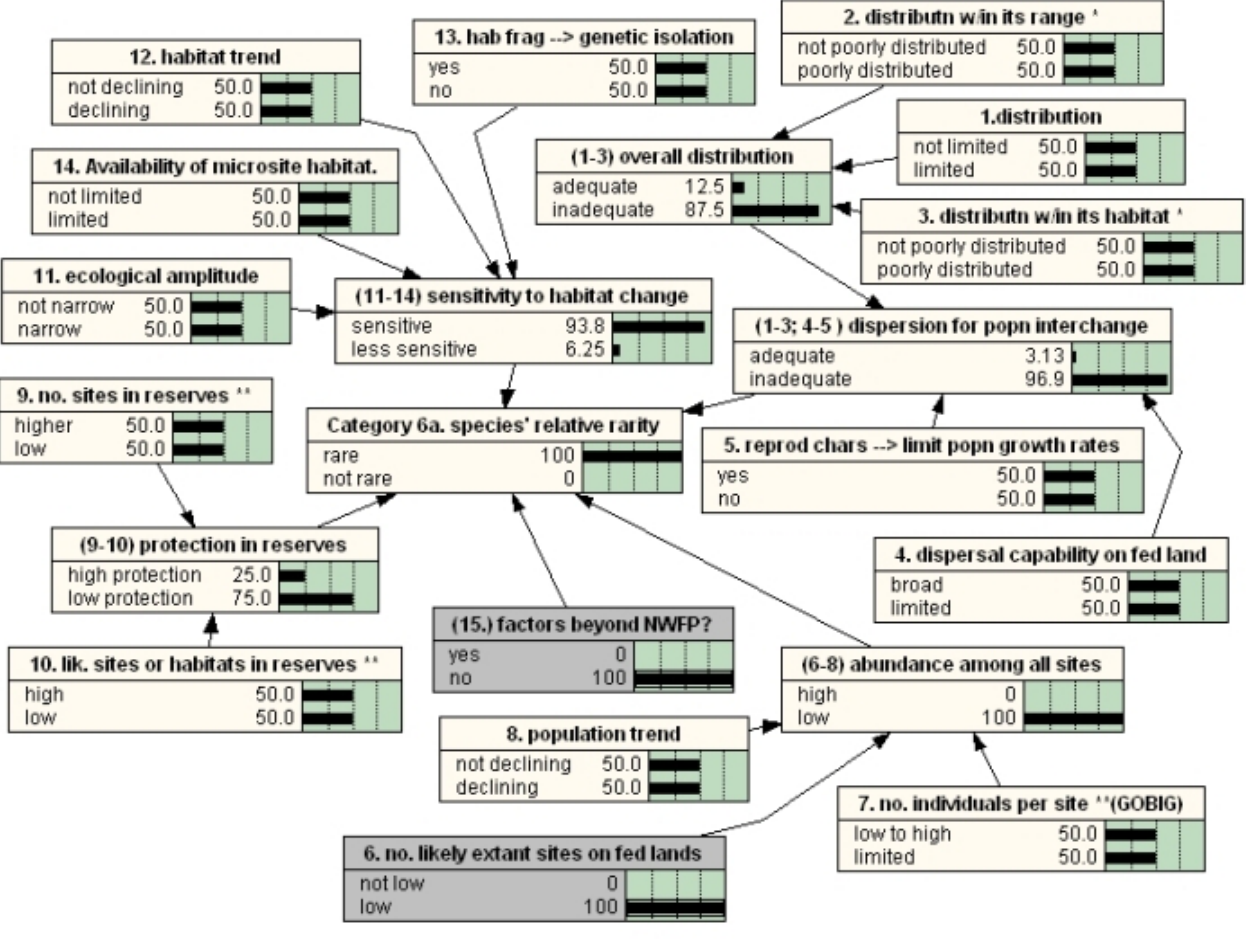
Fig. 7. Bayesian belief network (BBN) submodel for determining part of evaluation category 6, species relative rarity. See Table 2 for Record of Decision guidelines used to develop this